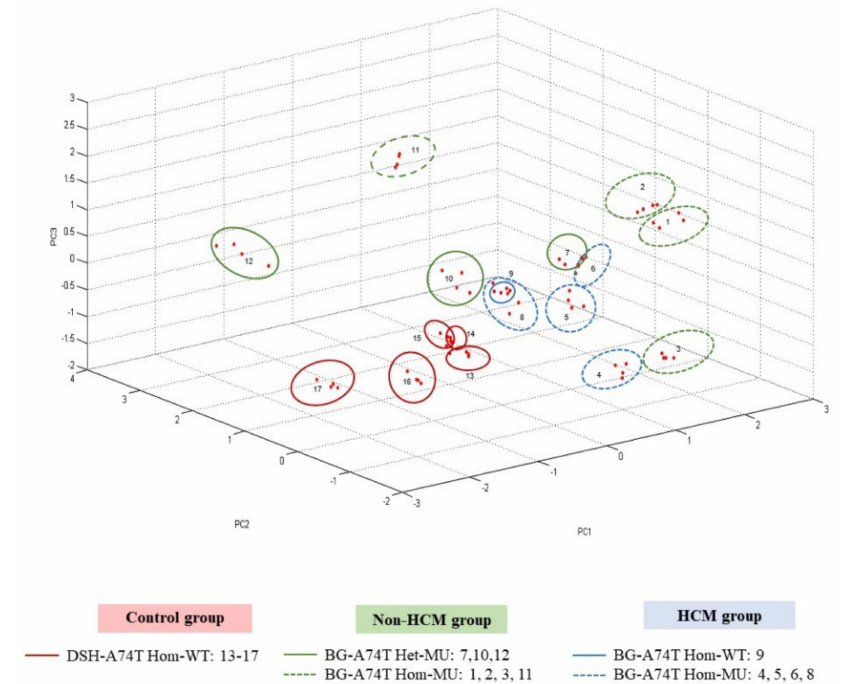
Figure 6. The analysis of MALDI-TOF mass spectrometry. A three-dimensional principal component analysis scatterplot (3D-PCA) of the control group, non-HCM group, and HCM group in each pattern of MYBPC3-A74T gene mutation. HCM = hypertrophic cardiomyopathy; DSH = Domestic short hair; BG = Bengal cat; WT = wild-type; MU = mutant.